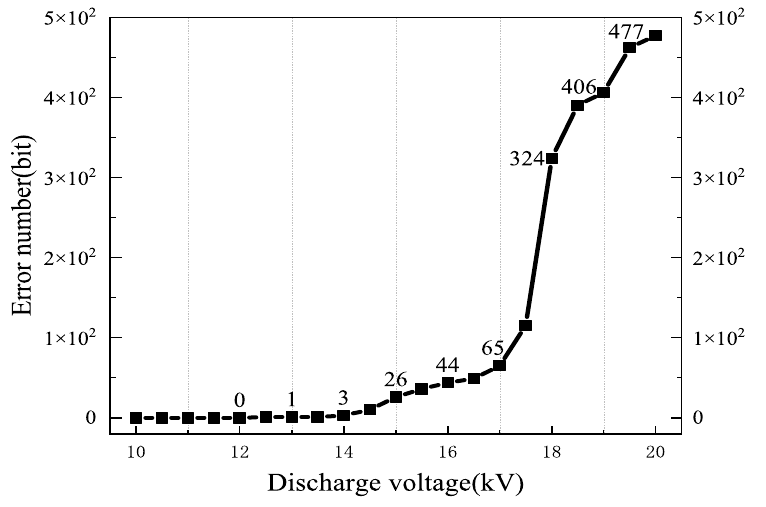
Figure 7. Error number curve with ESD